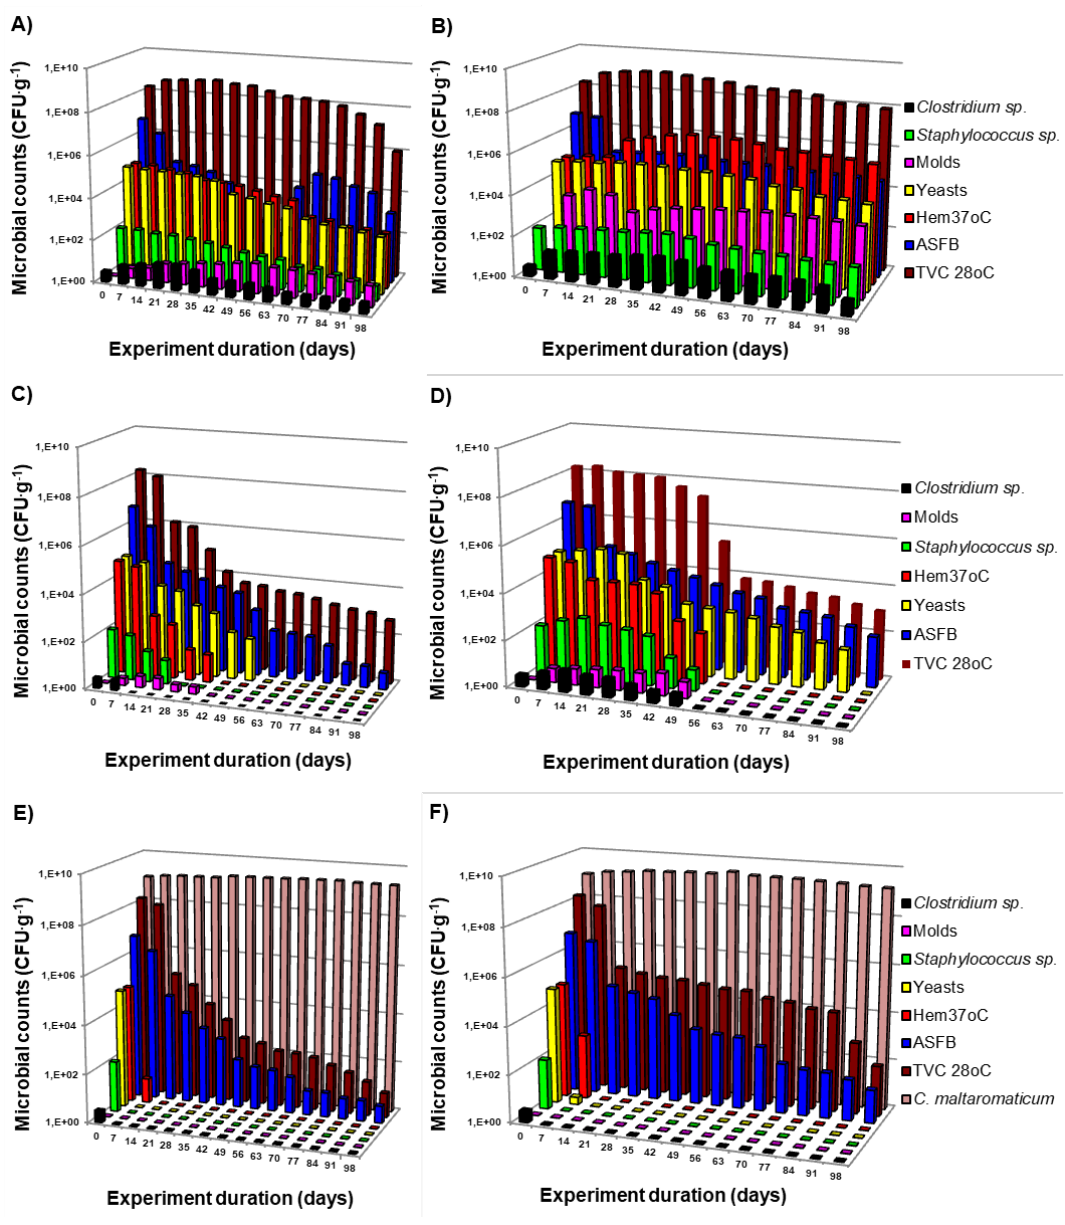
Figure 2. The mean (of three replicates) total viable counts (CFU g −1 ) of mesophilic bacteria (TVC 28 °C), hemolytic mesophilic bacteria (Hem 37 °C), Staphylococcus sp., Clostridium sp., aerobic spore-forming bacteria (ASFB), yeasts, and molds in: ( A ) Control feed (CF 4 °C) stored at a temperature of 4 °C, ( B ) control feed (CF 20 °C) stored at a temperature of 20 °C, ( C ) feed supplemented with 20% amaranth meal (AF 4 °C) stored at a temperature of 4 °C, ( D ) feed supplemented with 20% amaranth meal (AF 20 °C) stored at a temperature of 20 °C, ( E ) feed supplemented with 20% amaranth meal and Carnobacterium maltaromaticum bacteria (ACF 4 °C) stored at a temperature of 4 °C, and ( F ) feed supplemented with 20% amaranth meal and Carnobacterium maltaromaticum bacteria (ACF 20 °C) stored at a temperature of 20 °C during a 98 day experiment. The mean values, standard deviations, standard errors, and confidence interval of three replicates of microbial counts are shown in Table S2 (Supplementary Materials).